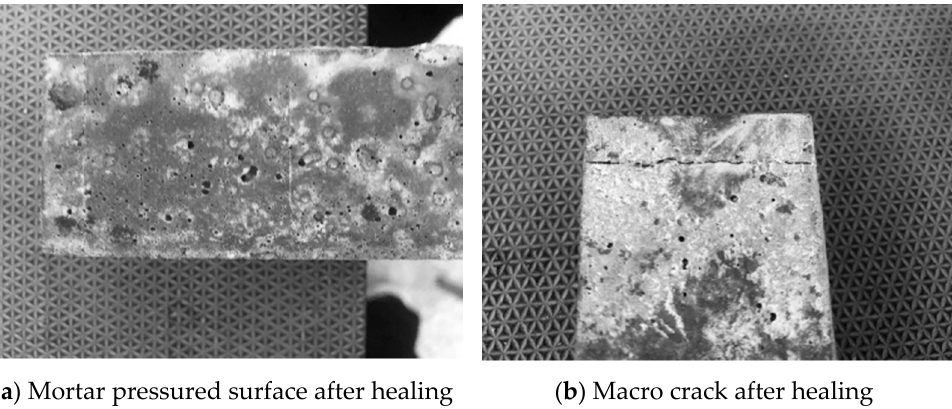
Figure 7. ( a , b ) Microcapsule self-repairing cement specimens after healing.